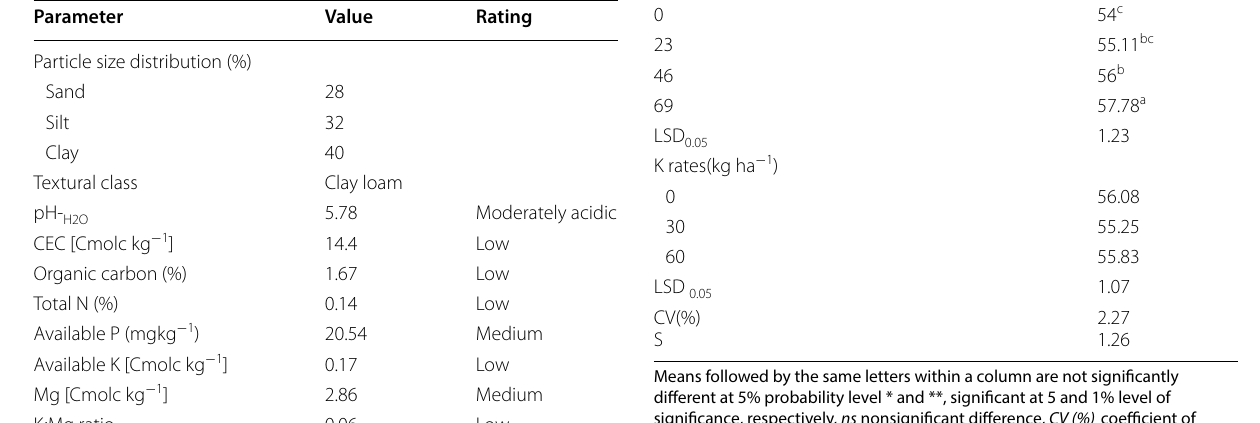
Table 1 Some physical and chemical properties of soils